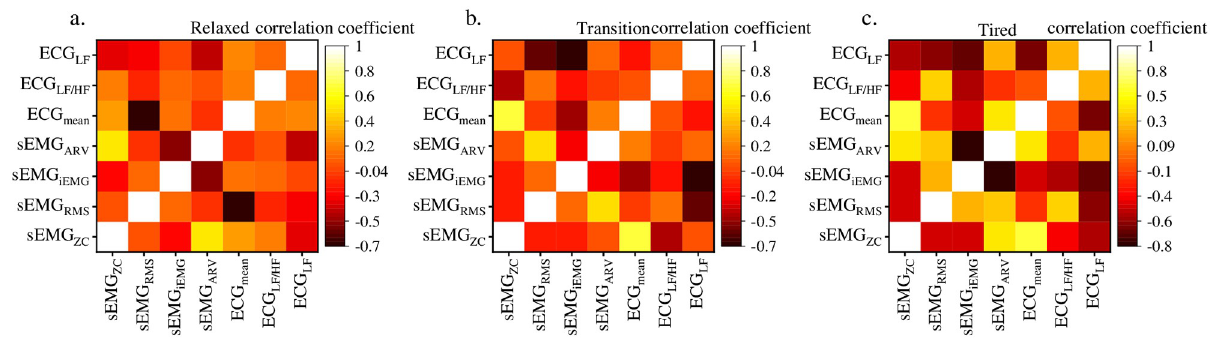
Fig 10. Correlation coefficients of sEMG and ECG time domain eigenvalues, a. Relaxed, b. Transition, c. Tired.